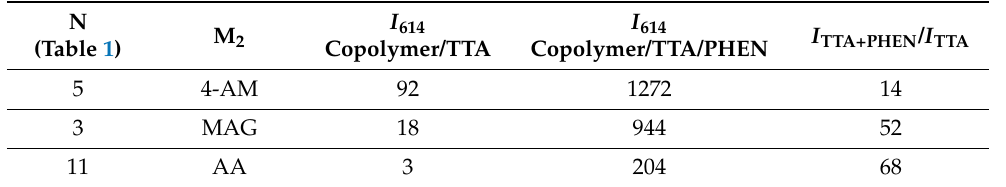
Table 3. The I 614 values for complexes of Eu 3+ with VPA copolymers in aqueous solutions in the presence of